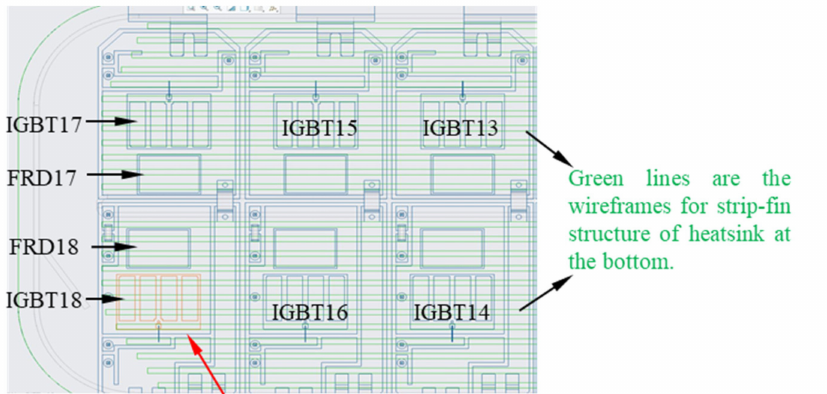
Figure 8. The placement design of power dies in the boost unit. The coupling of heat-flow paths for parallel power dies will also affect the size of contact area between the heat sink and coolant. For a single phase in GM_1 or GM_2, the cross-sectional area perpendicular to the heat-flow direction of the upper side are not significantly different from that of the lower side (see Figure 7b), but their SFs exhibit distinct characteristics between the upper side and lower side for both IGBT and FRD dies. These are attributed to the different lateral couplings of heat-flow paths for the parallel power dies due to the inconsistent placement design of parallel power dies on a heat sink. Figure 9 shows the placement design of power dies in GM_1 and GM_2, where the green lines are the wireframe of the liquid cooler. The number of parallel power dies are two for every phase in GM_1 and GM_2, but the spacing of the parallel power dies is different from each